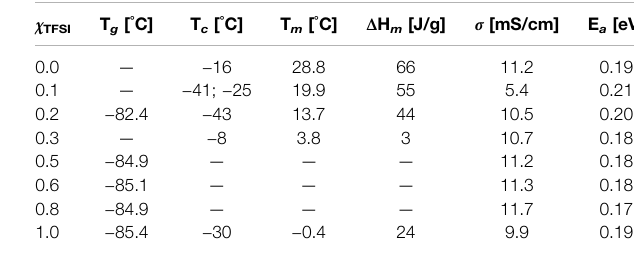
TABLE 1 | Temperature of glass transition (T g ), temperature of crystallization (T c ), temperature of melting (T m ), enthalpy of melting (H m ), ionic conductivity ( σ ) at 60 ° C, and activation energy (E a ) of the pure liquids and their binary mixtures as a function of composition ( χ TFSI